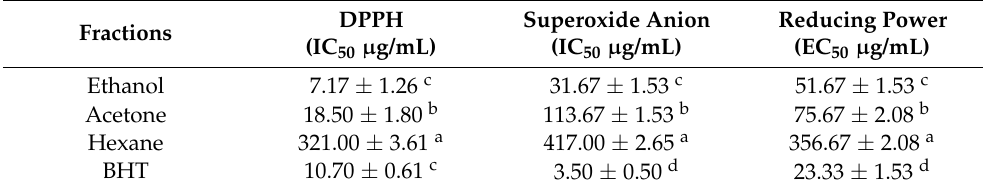
Table 3. DPPH radical-scavenging activity, superoxide anion radical-scavenging activity, and FRAP assays. Means (three replicates) followed by at least one same letter within a row are not significantly different at p <